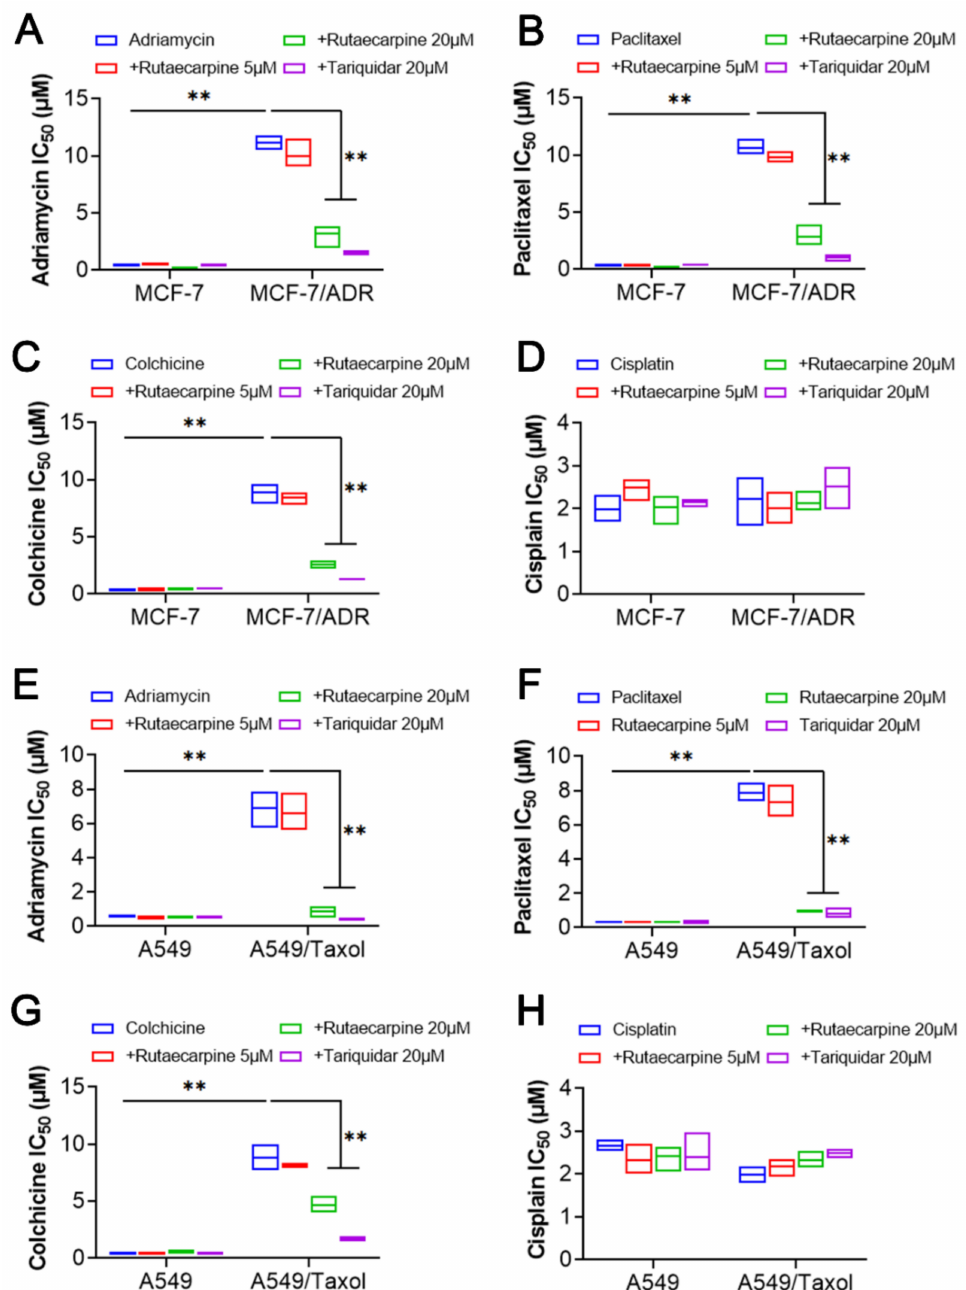
Figure 1. The effects of rutaecarpine on the IC 50 values of different anticancer drugs in parental and ABCB1-overexpressing cancer cells. IC 50 values of ( A ) adriamycin, ( B ) paclitaxel, ( C) colchicine, and ( D ) cisplatin in parental MCF-7 and drug-resistant ABCB1-overexpressing MCF-7/ADR cells. IC 50 values of ( E ) adriamycin, ( F ) paclitaxel, ( G ) colchicine, and ( H ) cisplatin in parental A549 and drug-resistant ABCB1-overexpressing A549/Taxol cells with or without treatment of rutaecarpine. All data are presented from three independent experiments. ** p <